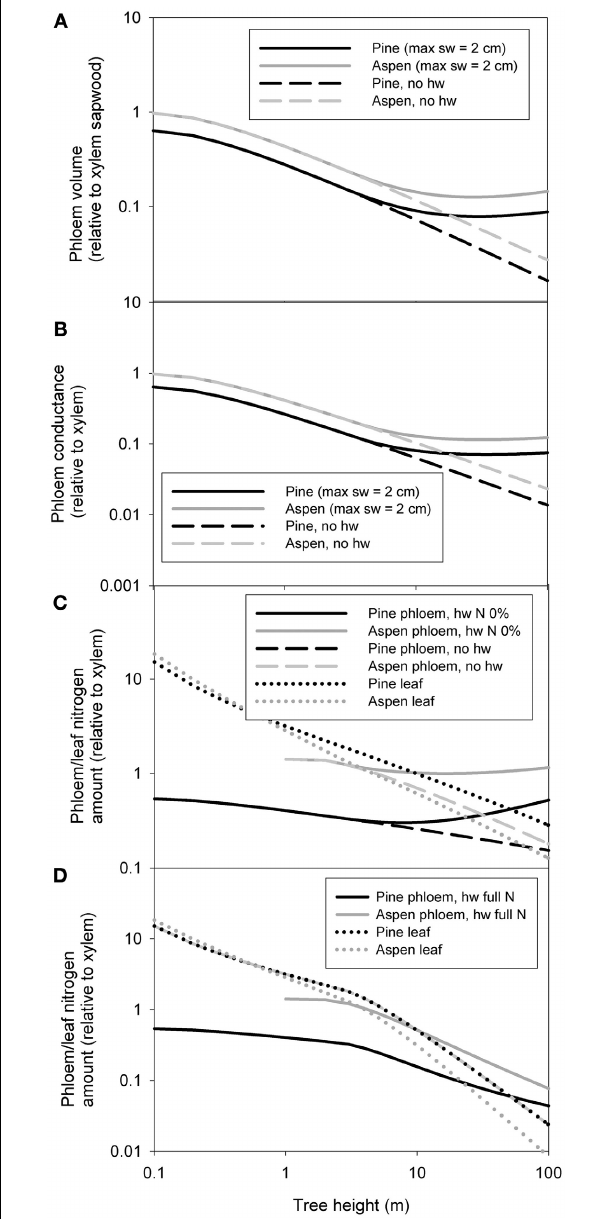
FIGURE 4 | The predictions for the whole tree phloem volume in relation to xylem sapwood volume (A), phloem hydraulic conductance in relation xylem hydraulic conductance (B), total phloem and leaf nitrogen content in relation to xylem hydraulic content for the scenarios in which the heartwood has the same nitrogen content as the sapwood and for the case of no heartwood (C), and phloem and leaf nitrogen content in relation to xylem hydraulic content for the case where the heartwood has the same nitrogen content as the sapwood (D). “sw = 2cm” refers to a scenario where maximum sapwood depth was assumed to be 2cm and the heartwood did not contain any nitrogen, “no hw” to a scenario of no heartwood formation, i.e., all of the xylem was assumed to be conducting, and “hw full N” a scenario where maximum sapwood depth was assumed to be 2cm and the heartwood nitrogen content was the same as that of the sapwood. In (B) the same area-specific conductivity was assumed for xylem and